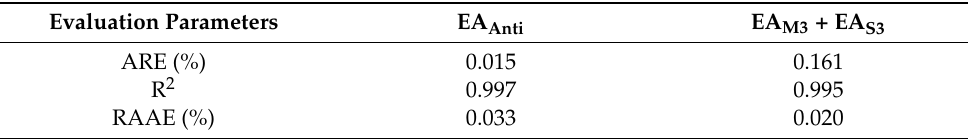
Table 4. Surrogate model accuracy evaluation parameters.